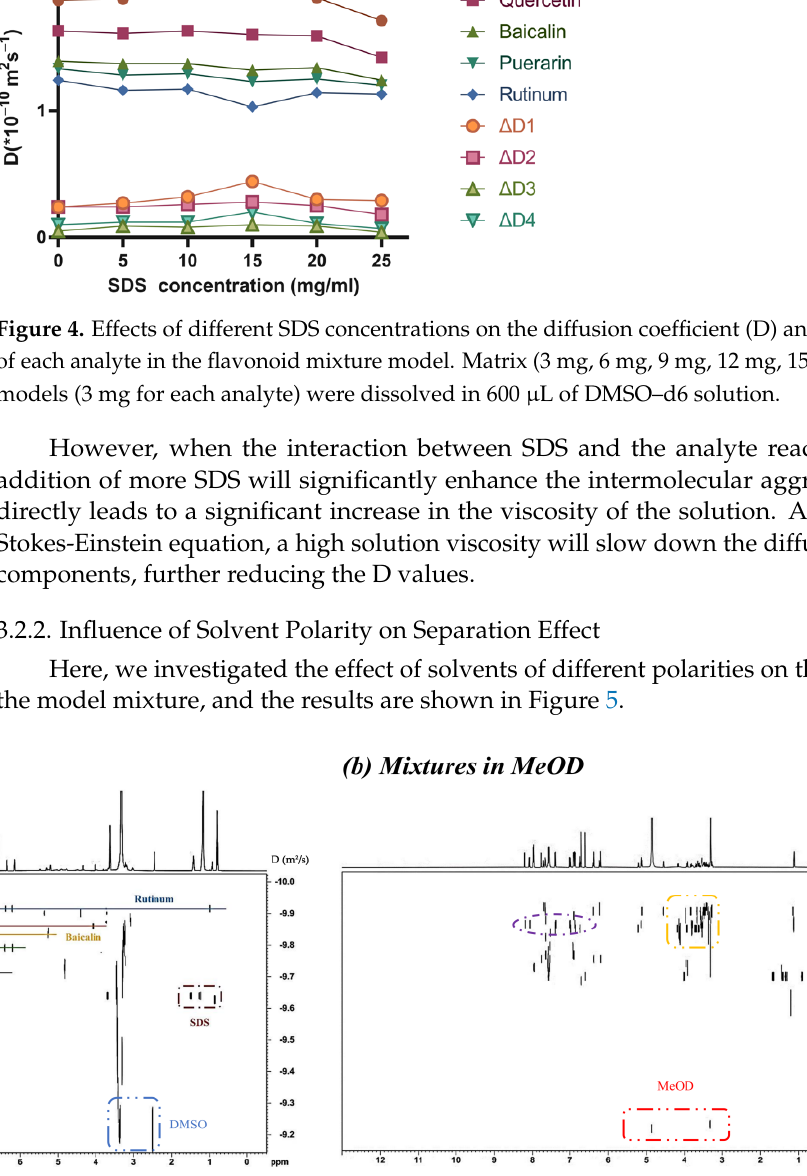
Figure 5. Typical 1 H 2D DOSY spectra of the flavonoid mixture model (3 mg per analyte) ( a ) dissolved in 600 µ L DMSO– d 6 solution, ( b ) dissolved in 600 µ L MeOD solution.